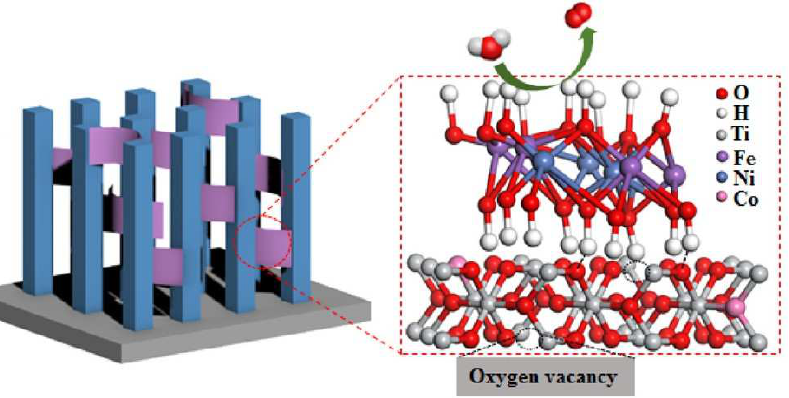
Figure 4. The hydrogen bonds formed between NiFe-LDH and Co-TiO 2 [13]. Copyright 2020 American Chemical Society.